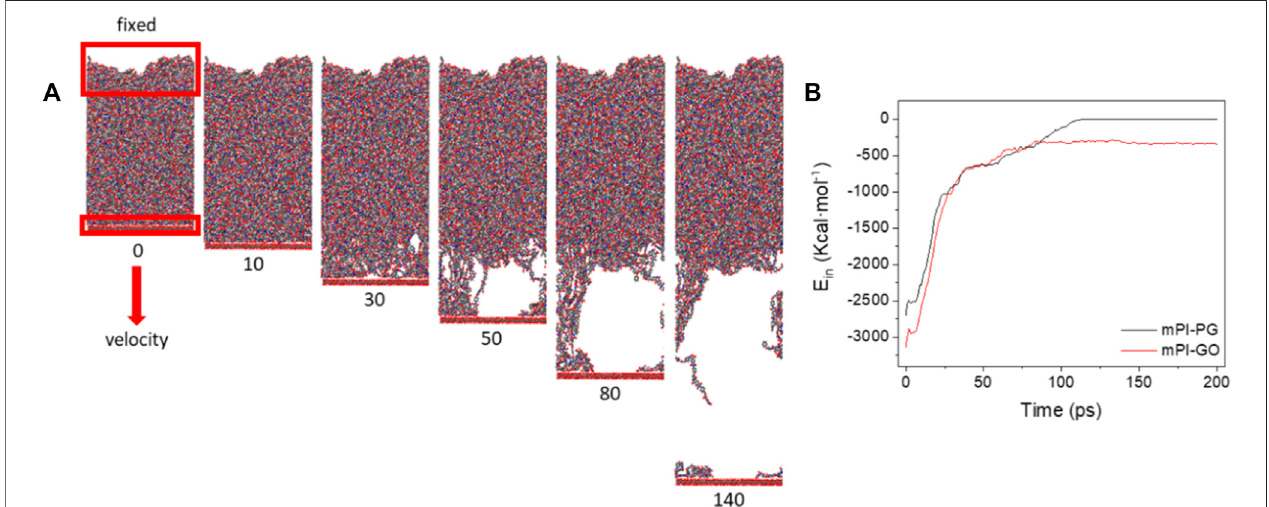
FIGURE 4 | (A) Snapshots of mPI/GO during the tensile process at different times (ps); (B) Change of E in during the process.